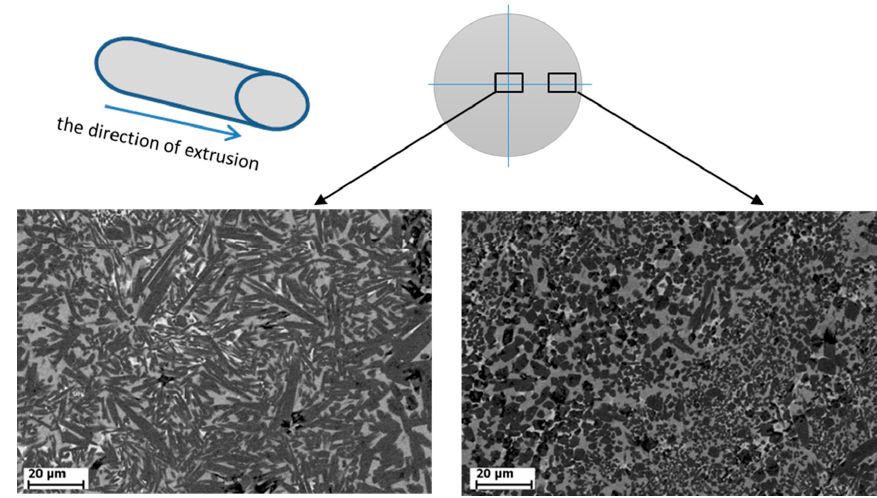
Figure 2. Microstructure of the cross section of the material synthesized during combustion